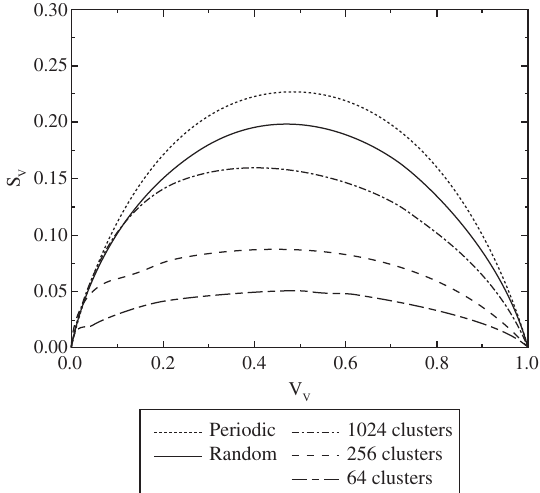
Figure 4. Interfacial area between recrystallized grains and matrix, S volume fraction, simulated by CA. The maximum in S for a periodic nuclei arrangement and less pronounced for clusters.